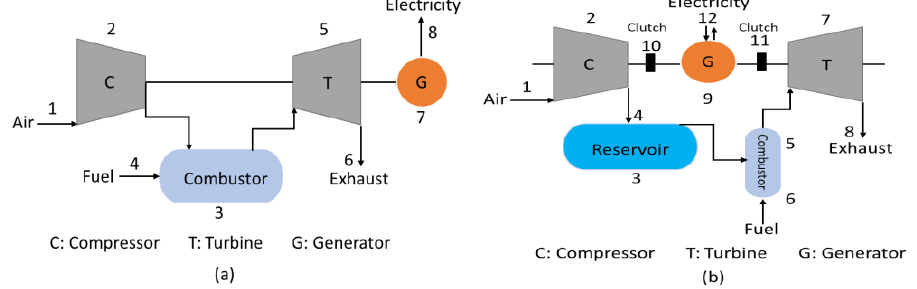
Figure 2. Gas turbine and CAES schematic diagram: ( a ) schematic diagram of gas turbine system; ( b ) schematic diagram of storing energy in gas turbine system.